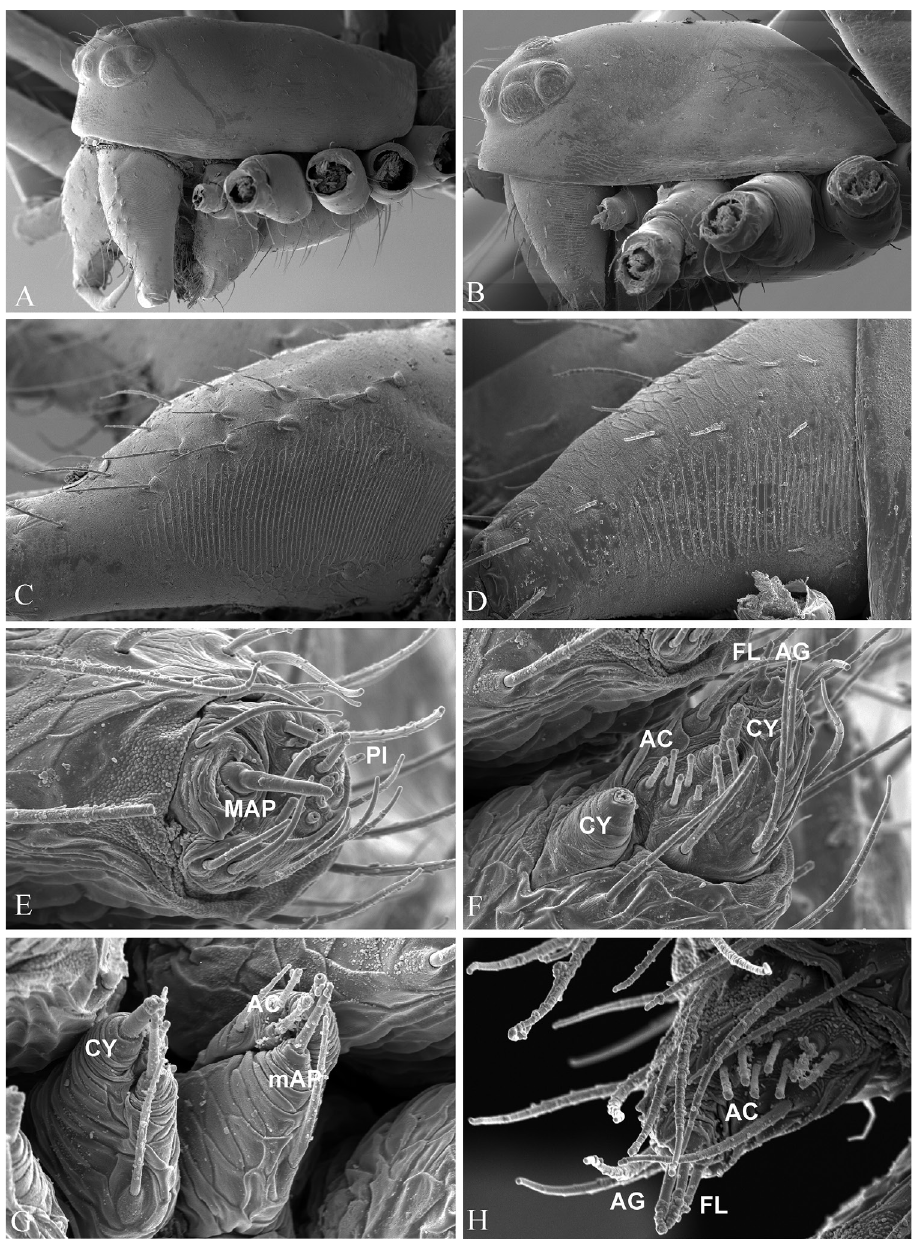
Figure 5. Nippononeta alpina comb. n. A male prosoma, lateral B female prosoma, lateral C male chelicerae, ectal D female chelicerae, ectal E female ALS F female PLS G female PMS H male PLS. Abbreviations: AC aciniform gland spigots; AG aggregate gland spigots; ALS anterior lateral spinneret; CY cylindrical gland spigot; FL flagelliform gland spigot; MAP major ampullate gland spigot; mAP minor ampullate gland spigot; PI piriform gland spigot; PLS posterior lateral spinneret; PMS posterior median